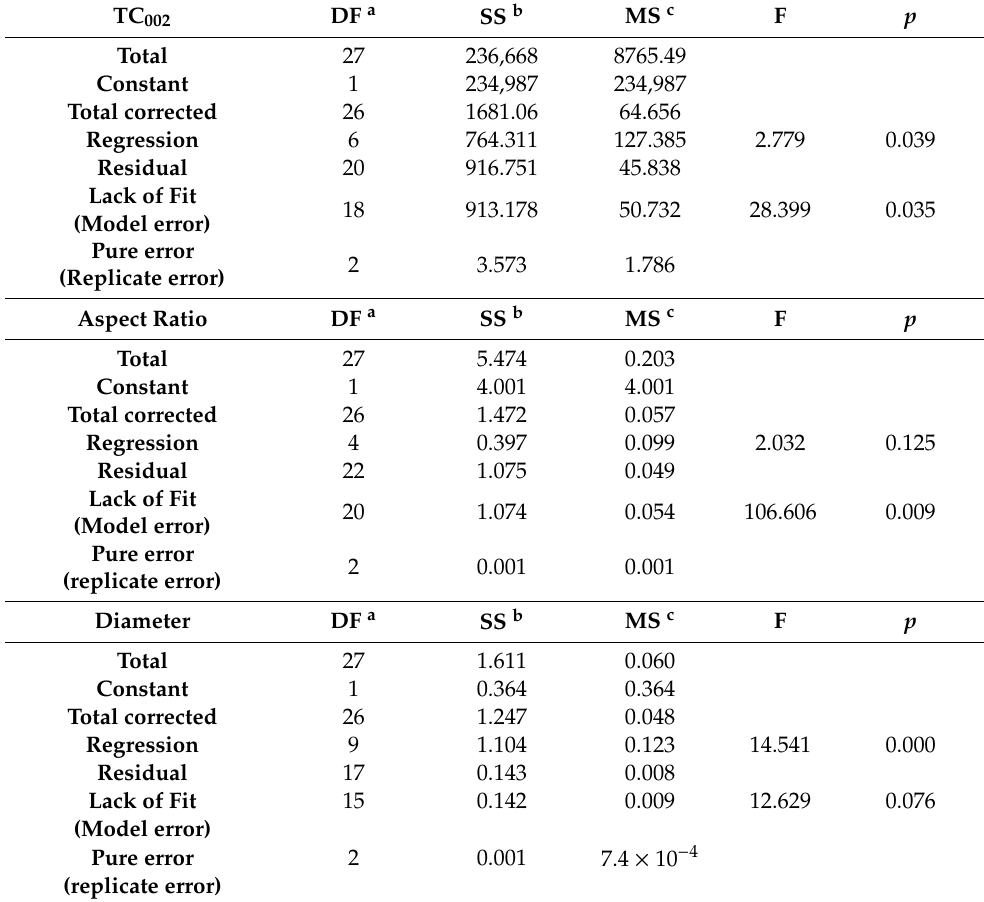
Table 2. The ANOVA table of the three responses.